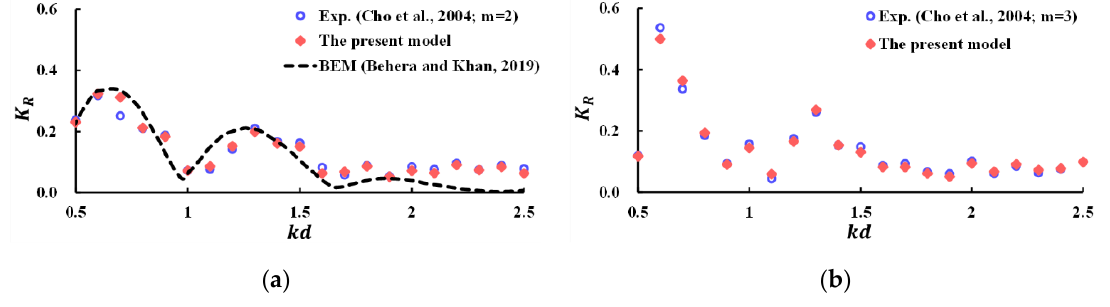
Figure 2. Validation of K R with the relative wave number kd for the different number of breakwaters: ( a ) two breakwaters m = 2, ( b ) three breakwaters m = 3.